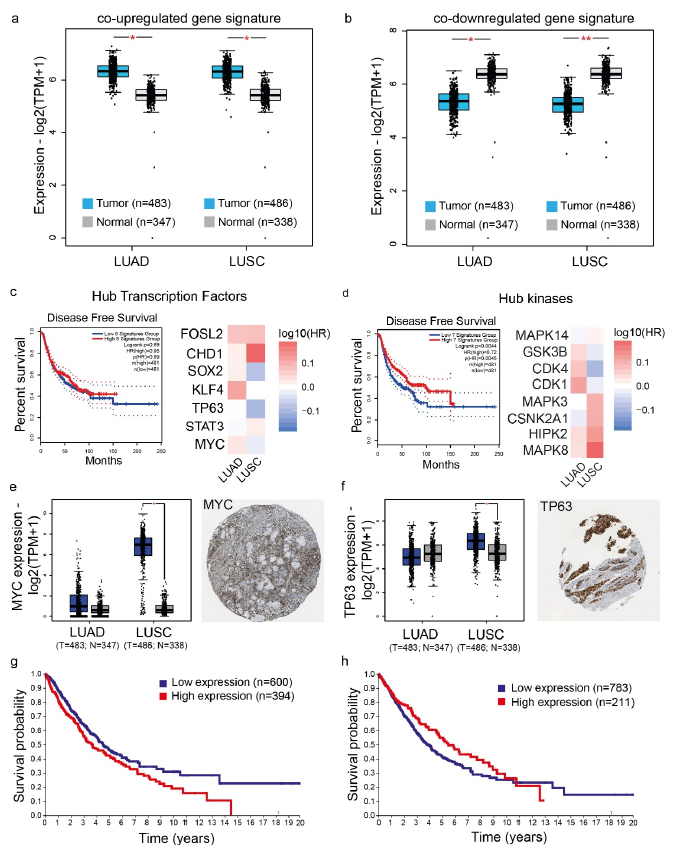
Figure 4. The expression patterns of the co-upregulated ( a ) and co-downregulated ( b ) gene signa- tures were verified in the TCGA-LUAD and TCGA-LUSC datasets, respectively (LUAD, 483 lung adenocarcinomas (T) and 347 normal (N) samples; LUSC, 486 lung squamous cell carcinomas (T) and 338 normal (N) samples). The significantly elevated expressions of the major hub transcription factors MYC, STAT3, TP63 and KLF4 were verified among LUAD and LUSC, respectively. The upregulated levels of the hub kinases CDK1, GSK3B, CSNK2A1 and MAPK14 were also validated in LUAD and LUSC tumors (*, p < 0.001; **, p < 0.0001). The Kaplan–Meier curves depict disease-free survival of lung patients with high or low expression in signatures composed of the transcription factors (FOSL2, CHD1, SOX2, KLF4, TP63, STAT3 and MYC) ( c ) or kinases (MAPK14, GSKB3, CDK4, CDK1, MAPK3, CSNK2A1, HIPK2, MAPK8) ( d ) acting as main hubs, respectively. High expression of the signature composed of the hub kinases was significantly associated with disease-free survival ( p < 0.05), but that of the hubs’ TFs was not. MYC and TP63 were significantly upregulated in LUSC (but not LUAD) patients, exhibited moderate protein expression ( e , f ), and showed a reverse pattern of association with patient survival ( p ≤ 0.05, Log-rank) ( g , h ). The TCGA-LUAD and TCGA-LUSC patient cohorts were analyzed using GEPIA2. IHC data were extracted from the Human Protein